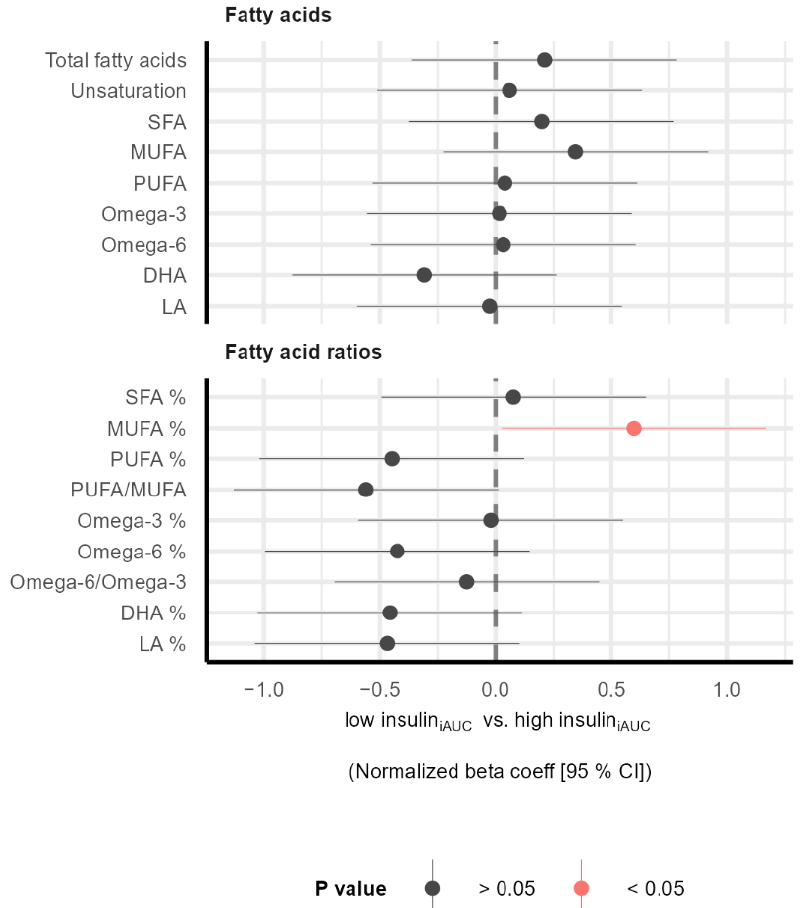
Figure 1. Fatty acids profile in plasma before intervention. The forest plot displays the normalized beta coefficients (mean difference) and 95% confidence interval for the difference between the low insulin iAUC and high insulin iAUC groups. Estimates on the left and right side of the zero-line translate to lower and higher in the high insulin iAUC group compared to the low insulin iAUC group, respec- tively. Color denotes the p value. Abbreviations: DHA: Docosahexaenoic acid, DHA%: Ratio of docosahexaenoic acid to total fatty acids, iAUC: incremental Area Under the Curve, LA: Linoleic acid, LA%: Ratio of linoleic acid to total fatty acids, MUFA: Monounsaturated fatty acids, MUFA%: Ratio of monounsaturated fatty acids to total fatty acids, Omega-3%: Ratio of omega-3 fatty acids to total fatty acids, Omega-6%: Ratio of omega-6 fatty acids to total fatty acids, PUFA: Polyunsaturated fatty acids, PUFA%: Ratio of polyunsaturated fatty acids to total fatty acids, SFA: Saturated fatty acids, SFA%: Ratio of saturated fatty acids to total fatty acids, Unsaturation: Degree of unsaturation. There were no differences in total cholesterol levels or lipid composition of lipoproteins between the low insulin iAUC and high insulin iAUC groups (Supplementary Figure S3) neither on the LP-IR score (data not shown). Despite this, we observed a tendency coherent with higher LP-IR score in the high insulin iAUC compared to the low insulin iAUC group: higher levels of large very low-density lipoproteins (VLDL) particles and lower levels of large HDL particles (Supplementary Figure S4). See Supplementary Table S3 for more information about all the NMR metabolites, fold-changes, p values, and adjusted p